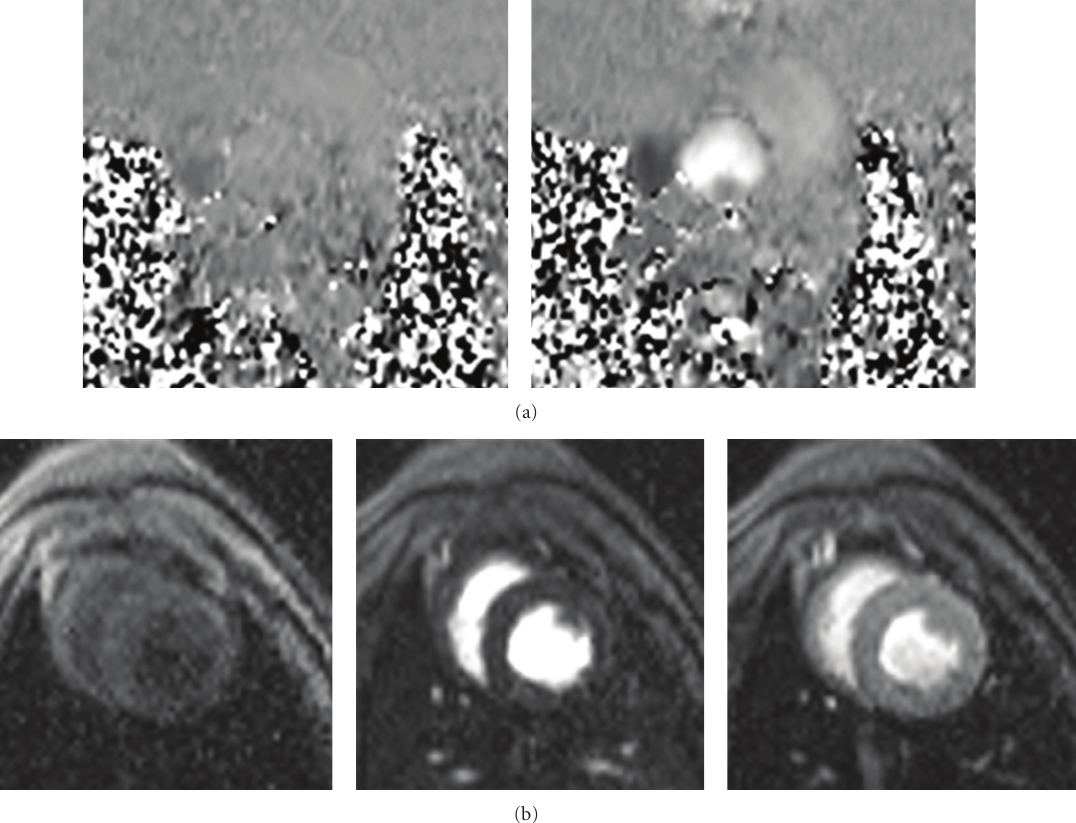
Figure 5: After-procedure evaluation. (a) Short-axis frames from a cine-phase contrast scan depict the blood flow through the aorta and atria after trocar removal and chest closure. These scans are used to confirm adequate valve opening and blood flow through the prosthetic valve and identify intra- or paravalvular regurgitation. Left: diastole. Right: systole. (b) A first-pass perfusion scan was performed during intravenous injection of Gd-DTPA contrast agent to confirm that myocardial blood flow was intact to all segments of the myocardium. From left to right the progression of time after venous injection of Gd-DTPA is